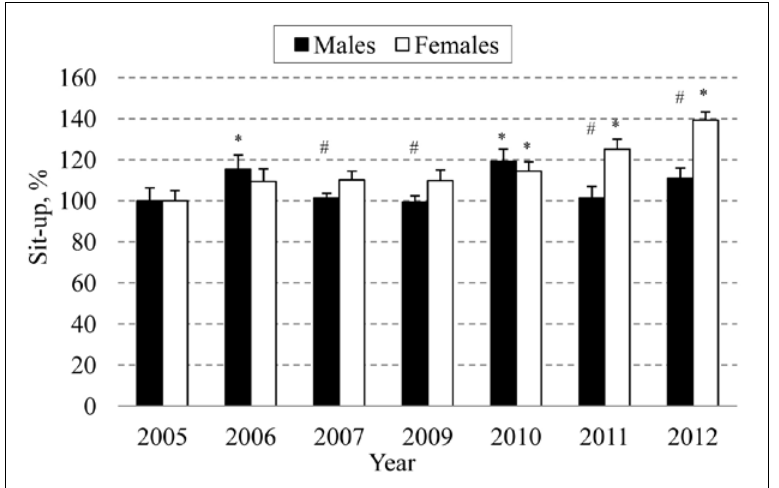
Figure 1. Sit up test results of males and